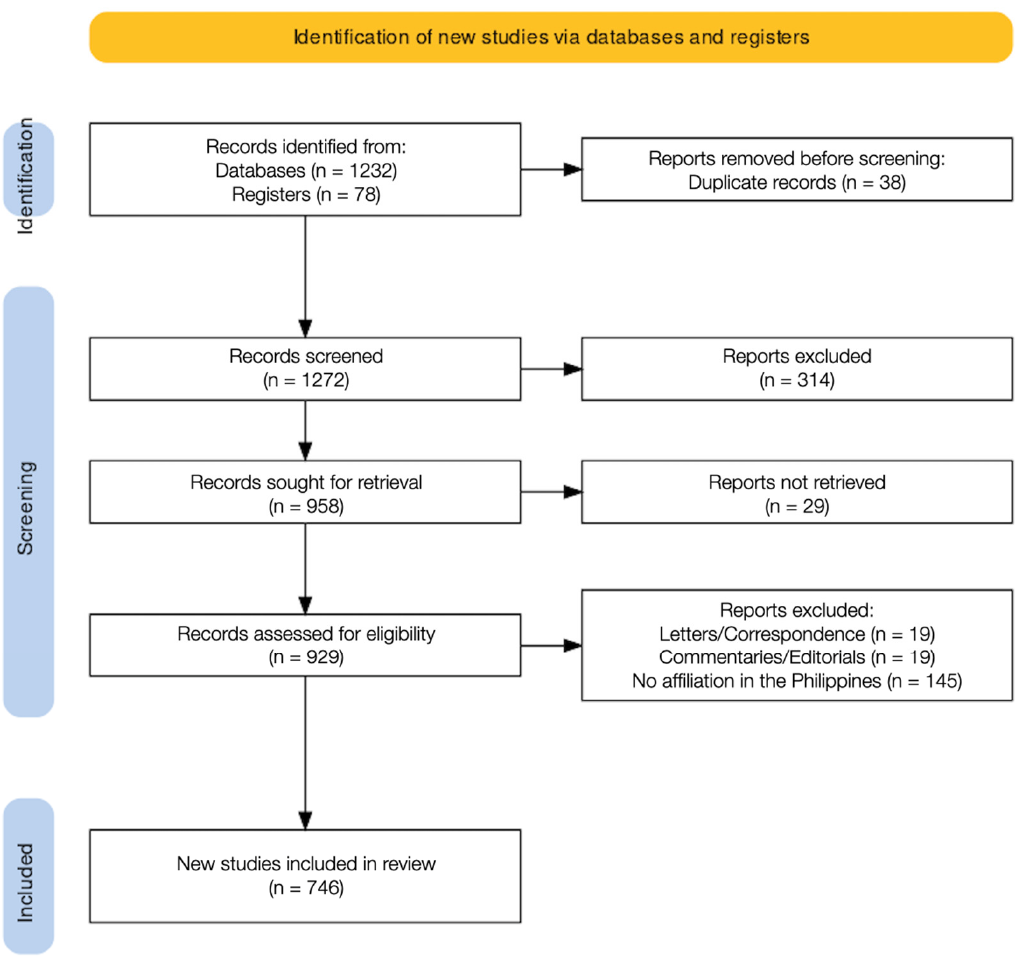
Figure 1. PRISMA flow diagram of study selection.